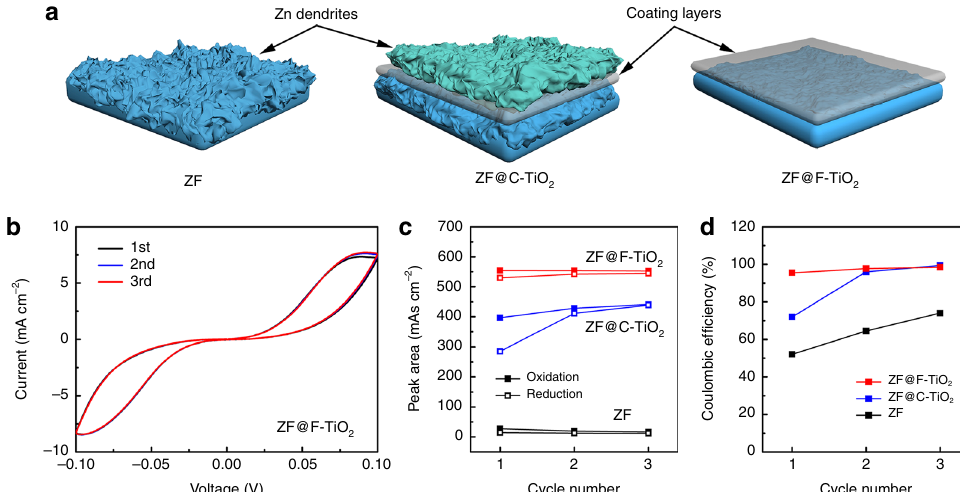
Fig. 2 Zn deposition behavior of the prepared anodes. a Schematic illustration of the Zn plating process with different coating layers. b CV curves of Zn – Zn symmetric cells using ZF@F-TiO 2 anode measured at 1 mV s − 1 . Peak areas of Zn stripping/plating reactions ( c ) and corresponding Coulombic ef fi ciency ( d ) of the prepared Zn anodes in Zn – Zn symmetric